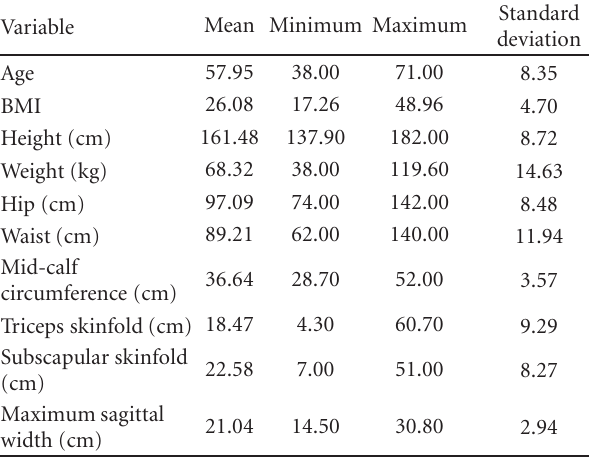
Table 3: Sample: Age and Anthropometric Measures ( N = 203).